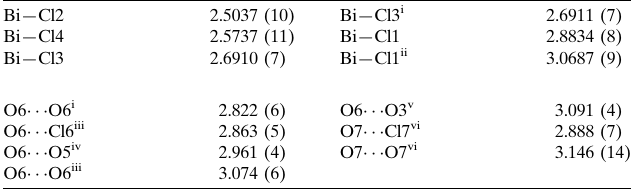
Selected interatomic distances and short contacts to water molecules (A˚